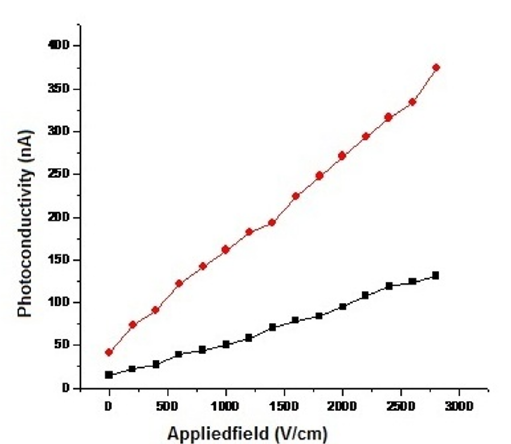
Figure 8. Field dependent conductivity of MMTG crystal